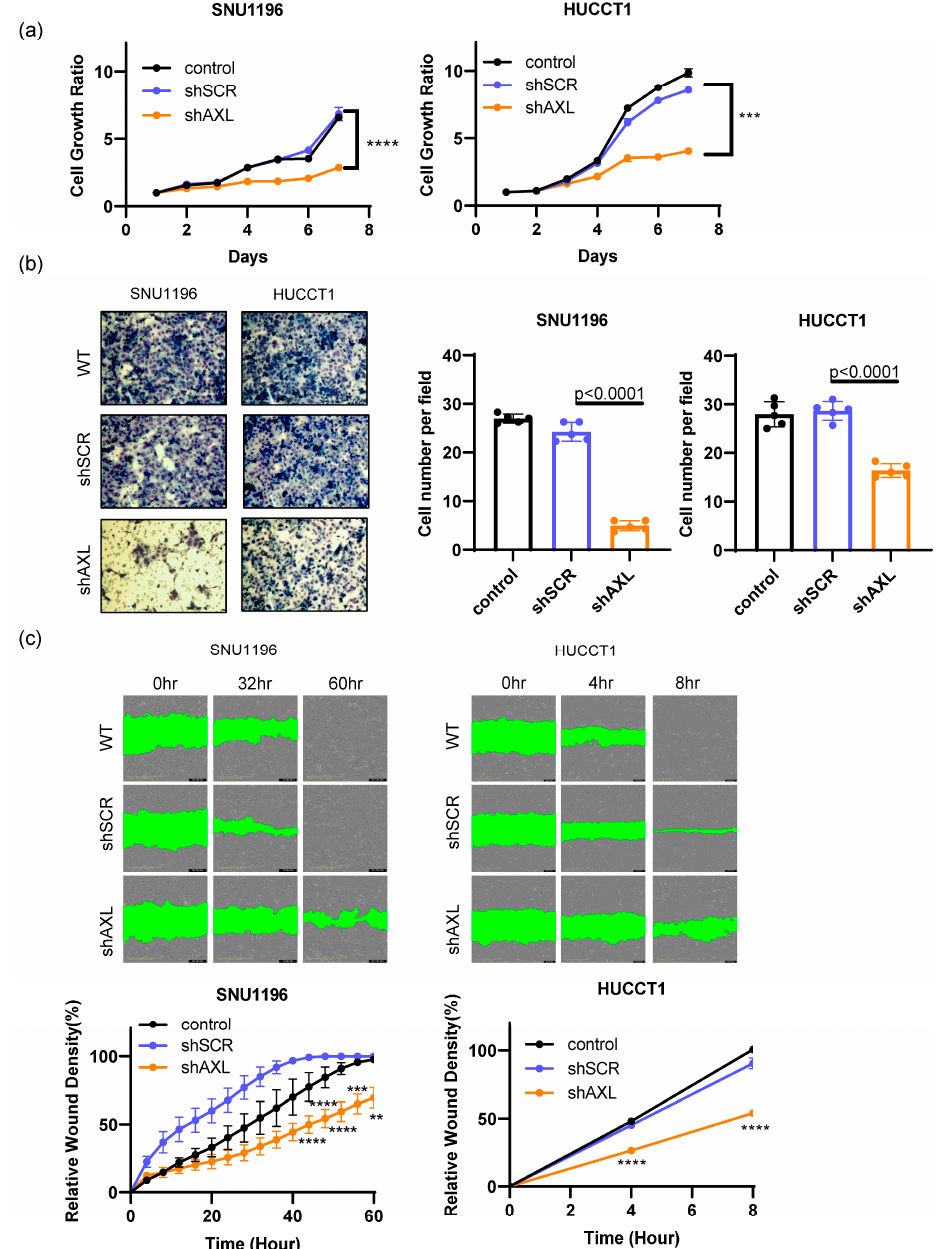
Figure 3. The roles of AXL in tumor cell growth and invasion/migration. ( a ) Inhibition of AXL expression using shRNA significantly decreased tumor cell growth in SNU1196 and HUCCT1 cells (two-way ANOVA, n = 3, *** p < 0.001, **** p < 0.0001). ( b ) Tumor cell invasion was assessed using Matrigel-coated invasion chambers. AXL inhibition significantly reduced the invasion of tumor cells through the Matrigel (two-way ANOVA, n = 5, p < 0.0001). ( c ) The role of AXL expression in tumor migration was determined by scratch assay. AXL knockdown significantly inhibited cell migration (two-way ANOVA, n = 3, ** p < 0.01, *** p < 0.001, **** p <